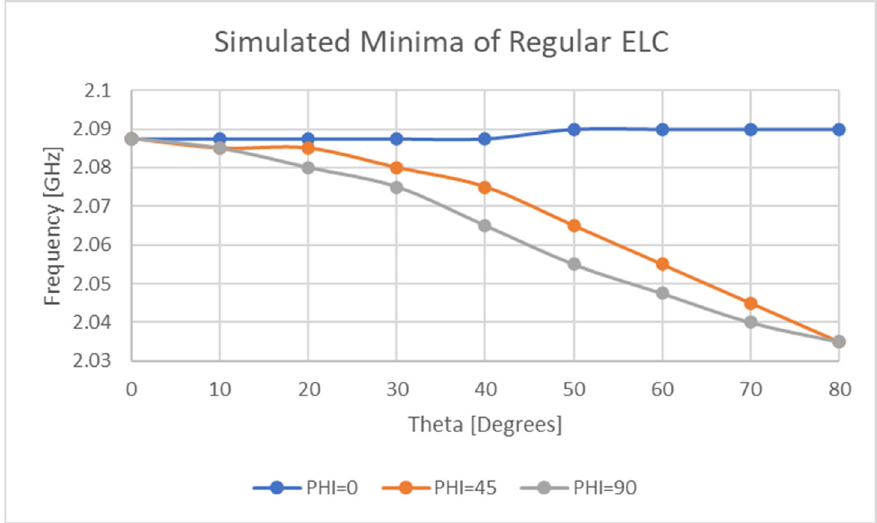
Figure 24. Orientation sensitivity of ELC resonant response.